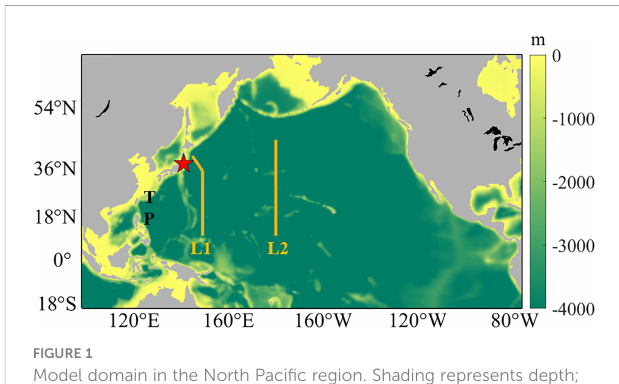
FIGURE 1 Model domain in the North Paci fi c region. Shading represents depth; red star represents the location of the Fukushima Dai-ichi Nuclear Power Plant. Lines L1 and L2 along 149°E and 180°E were selected for comparison and analysis of model results. T and P represent Taiwan and the Philippines,